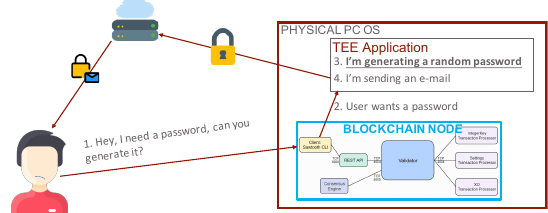
Figure 6. Password generation phase.